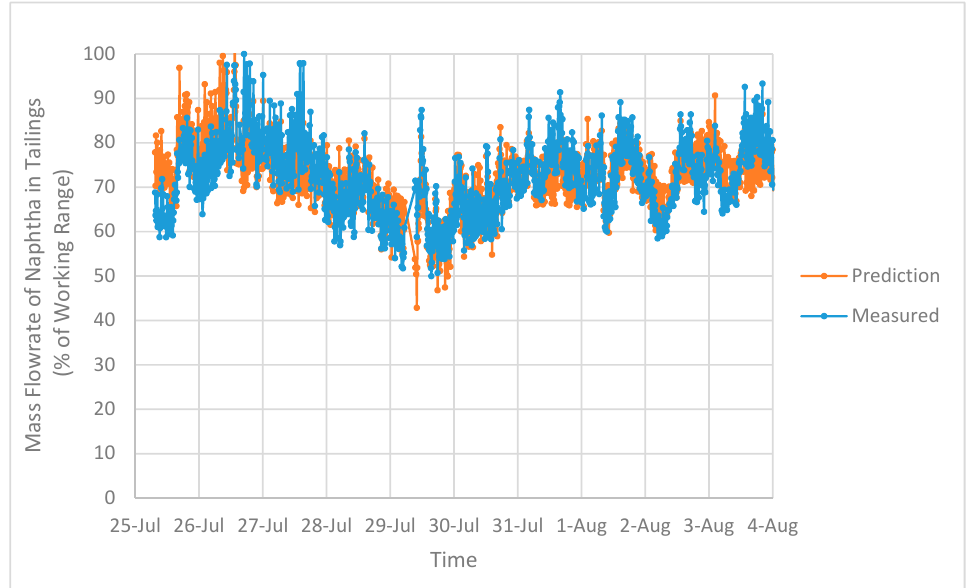
Figure 8. Measured and predicted mass flowrates of naphtha in the tailings for OP1.